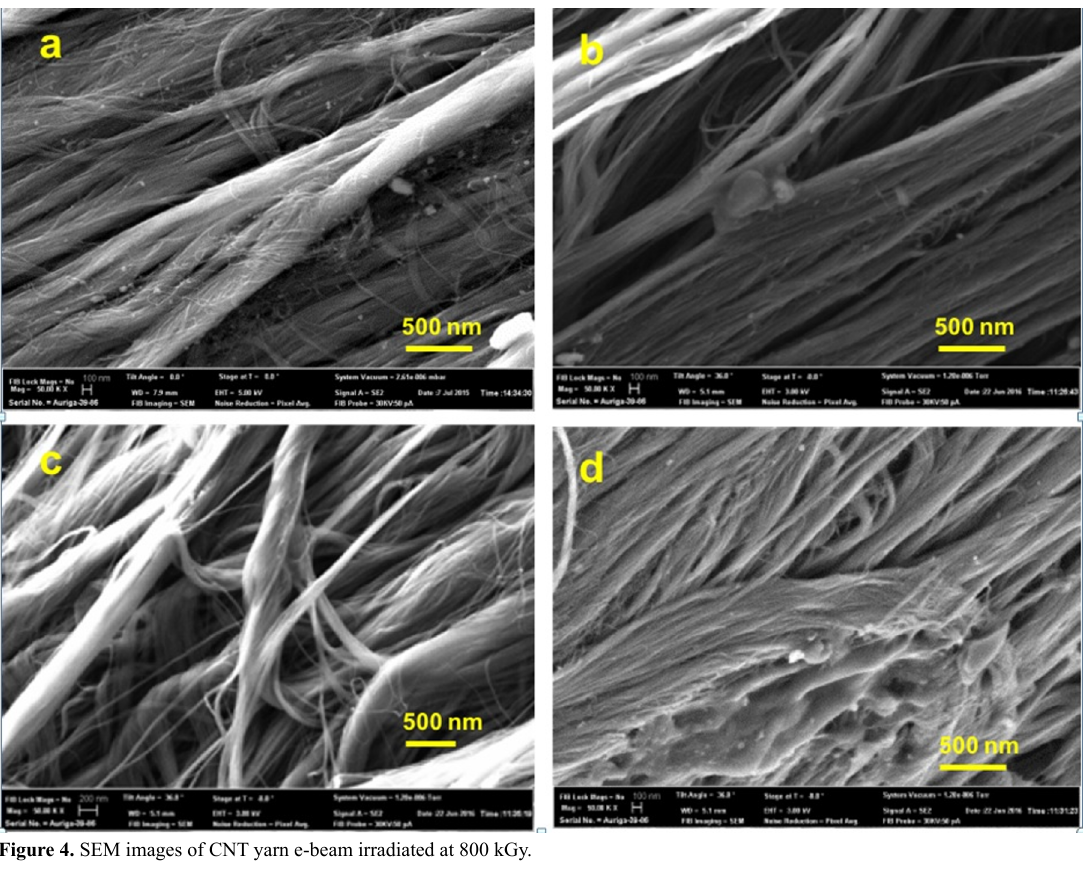
Figure 4. SEM images of CNT yarn e-beam irradiated at 800 kGy.